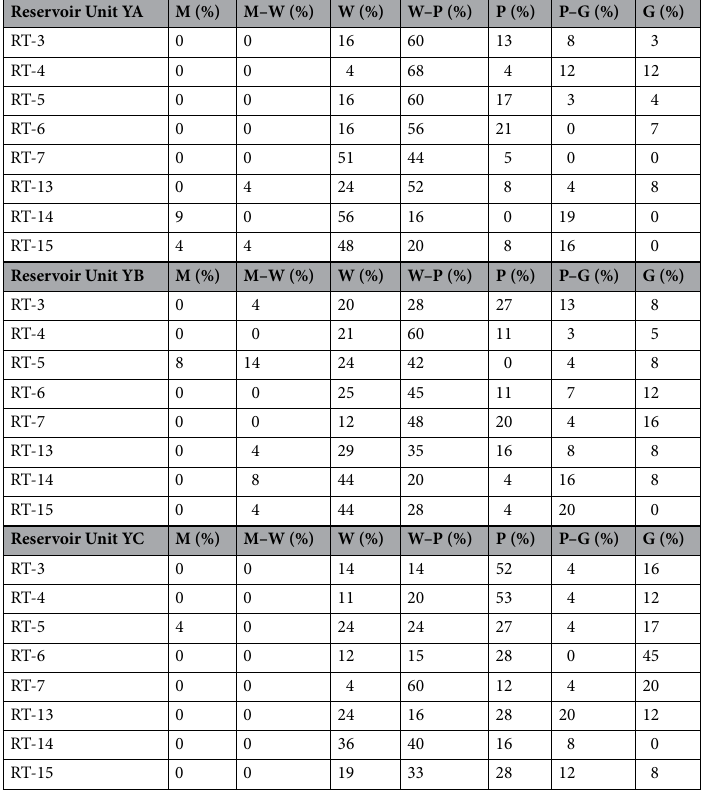
Table 1. Facies distribution of reservoir units of Yamama Formation. M: Mudstone, M–W: Mudstone– Wackestone, W: Wackestone, P: Packstone, P–G: Packstone–Grainstone, G: